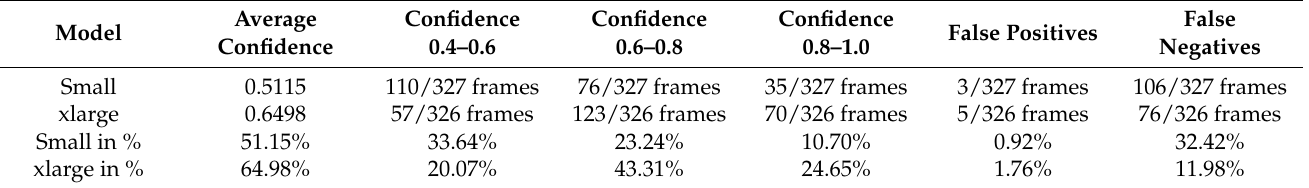
Table 3. Stabilization results from paper box detection over 10 s with a small and an xlarge